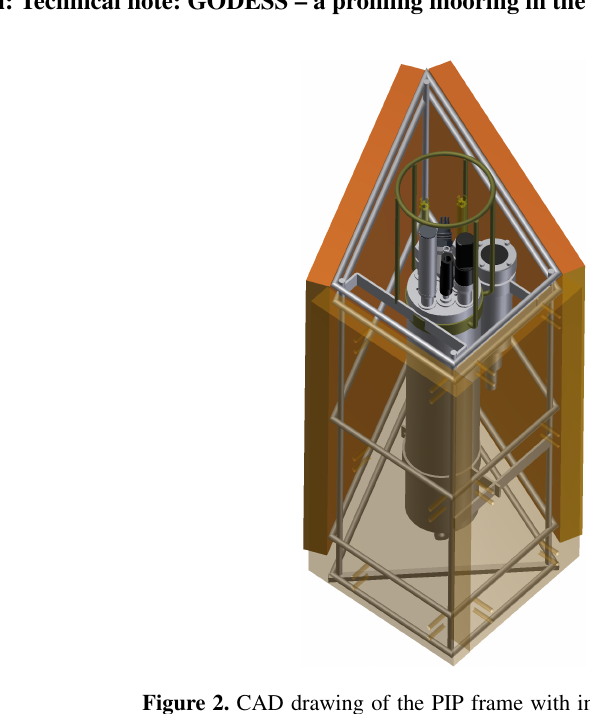
Figure 2. CAD drawing of the PIP frame with installed CTD and oxygen optode. Front sheets of syntactic foam are shown as trans-